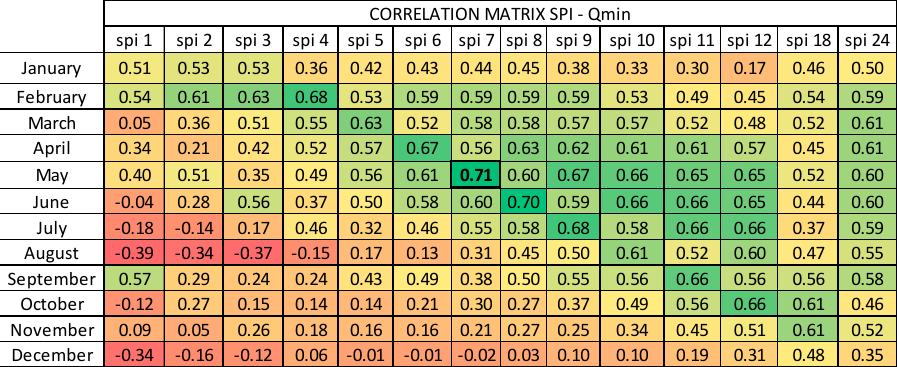
Figure 9. Relationship between Q min of the historical discharge series and SPI7 (May). The minimum annual value spring discharge, estimated by the exposed methodology, were plotted with the total discharge series modeled using equation (1). Figure 10 represents the detailed comparison between these two methods: results show that minimum discharge values are comparable. Generally, the Capodacqua di Spigno Spring minimum discharges occur at the end of the summer season (September), with values higher than 500 L/s. The two anomalies, due to drought events (2016–2017) are well represented by the SPI method as well as the proposed model, whose minimum values, match well with the withdrawals recorded by the local water agency Acqualatina S.p.A. for drinking purposes (assumed to be equal to the total spring discharge), which was not enough for satisfying civil water networks supply demands.